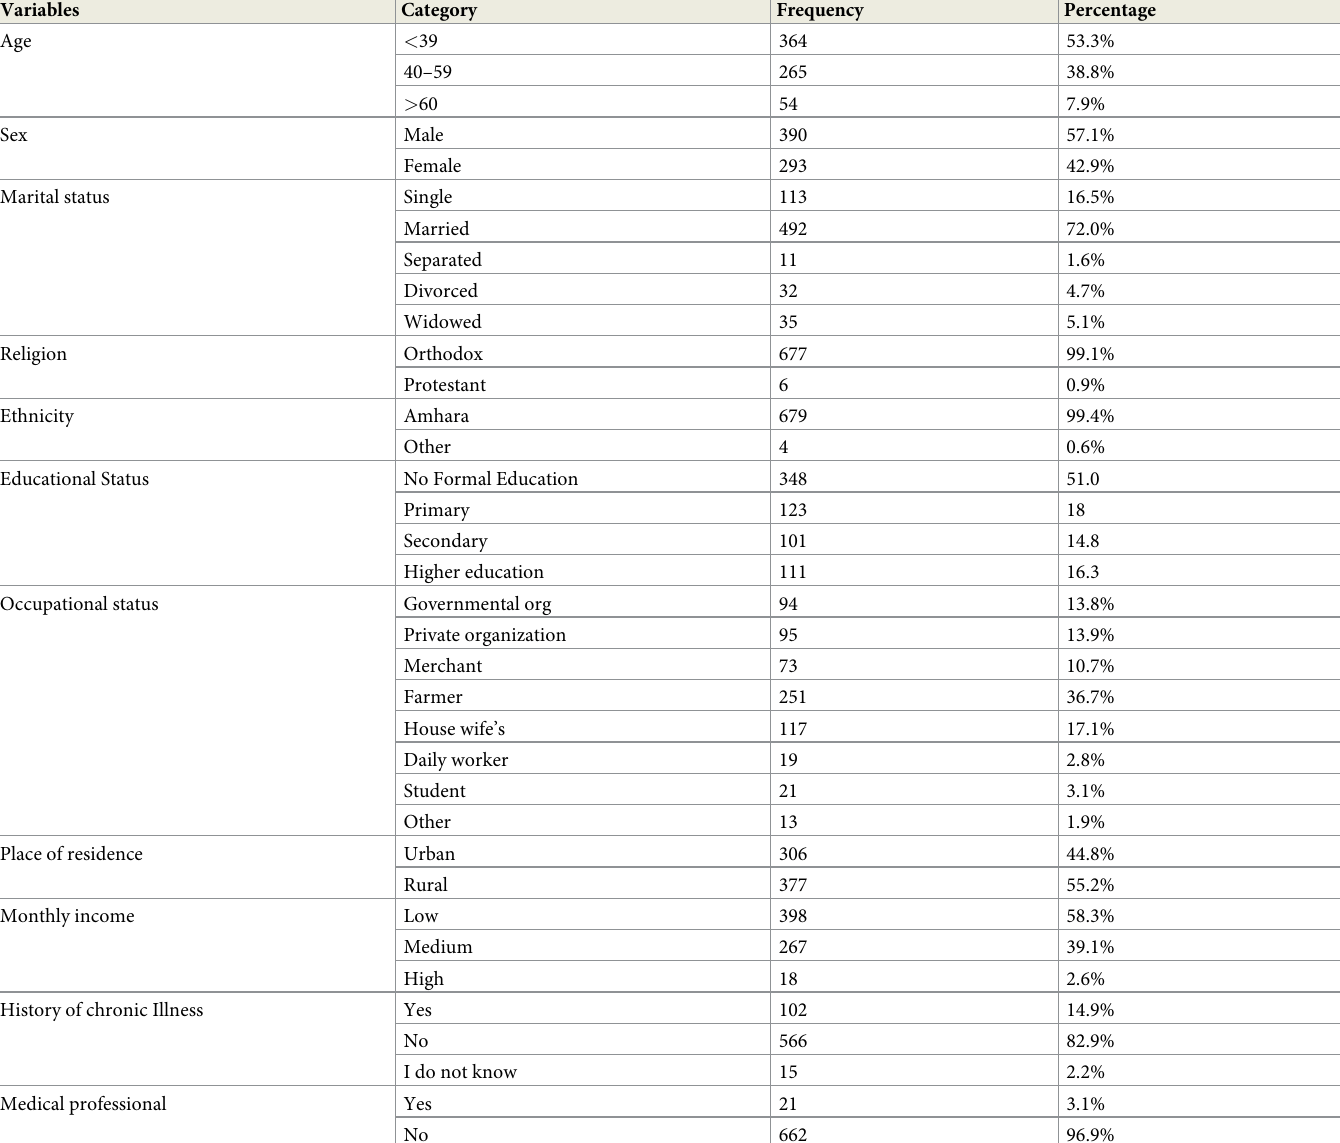
Table 2. Socio demographic characteristics of participants, North Shoa zone, Ethiopia,